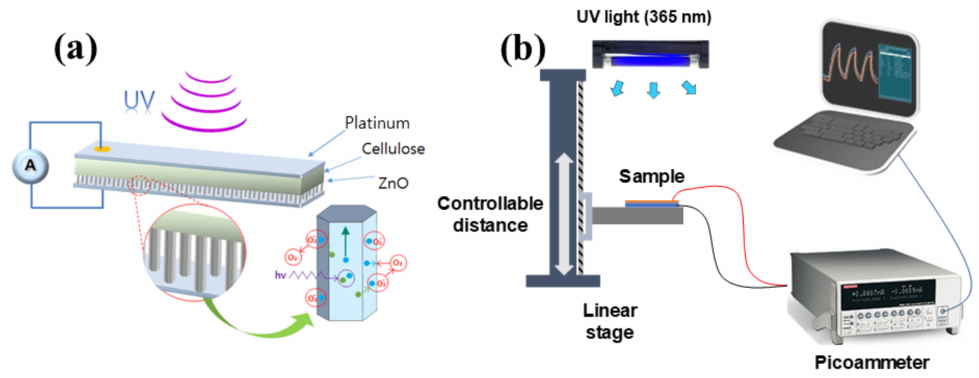
Figure 3. ( a ) Schematic of UV sensing ZCN and ( b ) UV-sensing test setup.